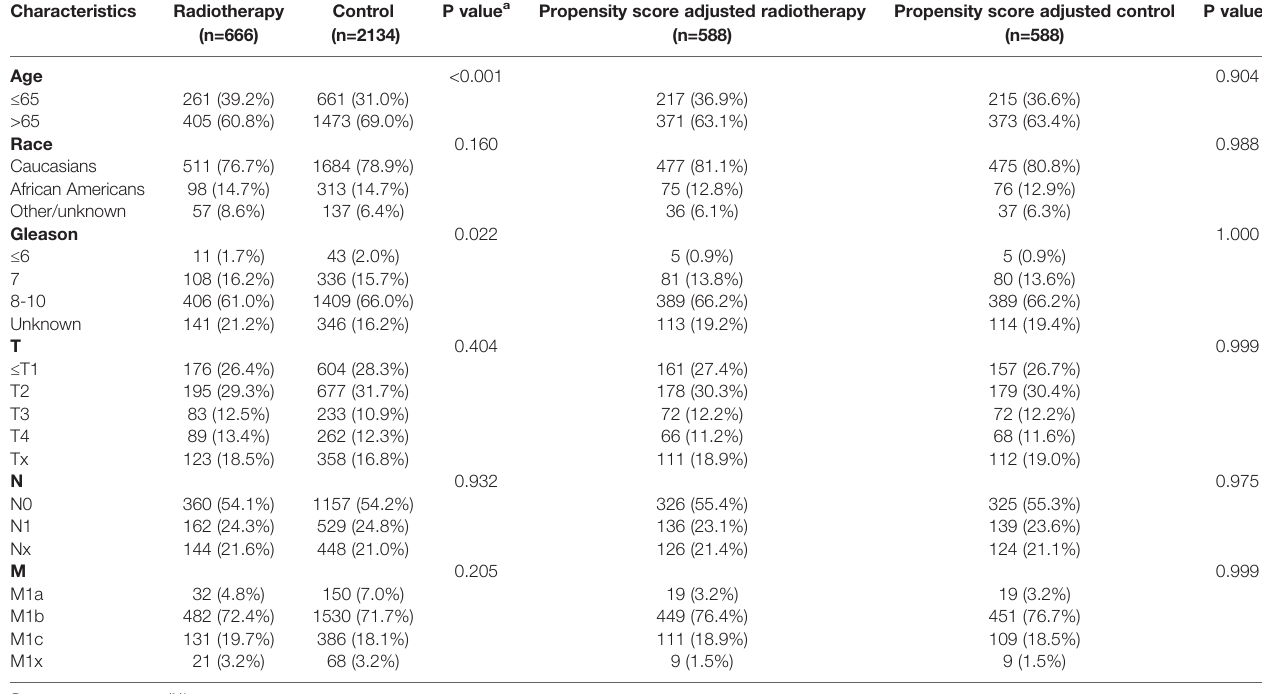
TABLE 7 | Clinicopathological characteristics of the PSA 40.1-80ng/ml subgroup strati fi ed according to treatment modality with and without propensity score matching. Characteristics